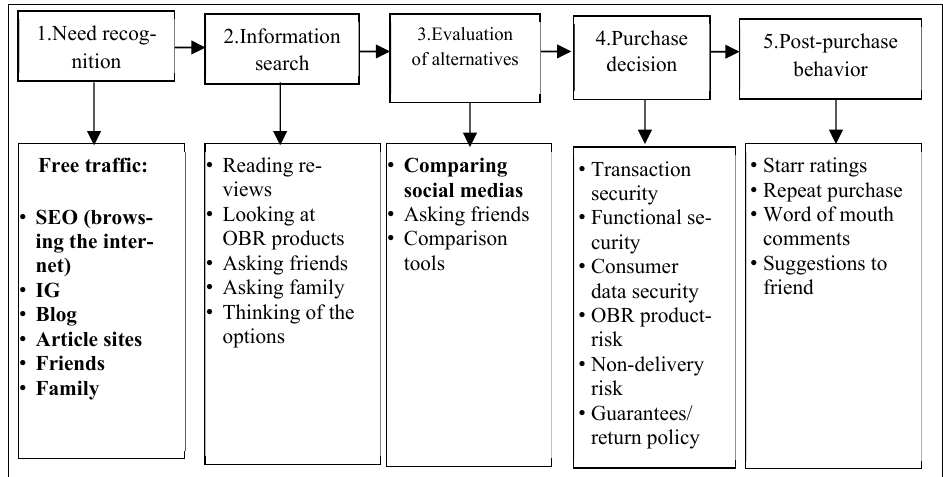
Fig. 1. Conceptual Model of Online OBR Purchase Decision Process via S-commerce Source: (Kusno et al.,